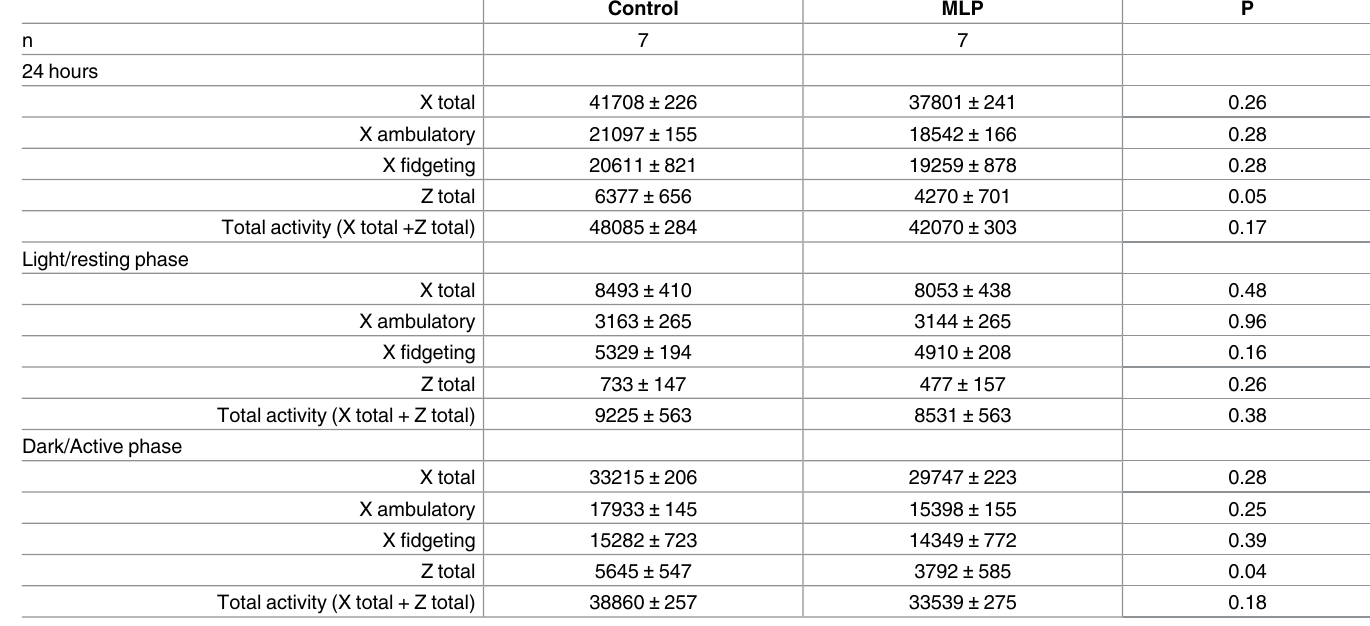
Table 2. Spontaneous cage activity, measuredas infra-red beam breaks in 12-wk-old MLP and Control offspring; values over 24 hours, and the distribution between light and dark phases are